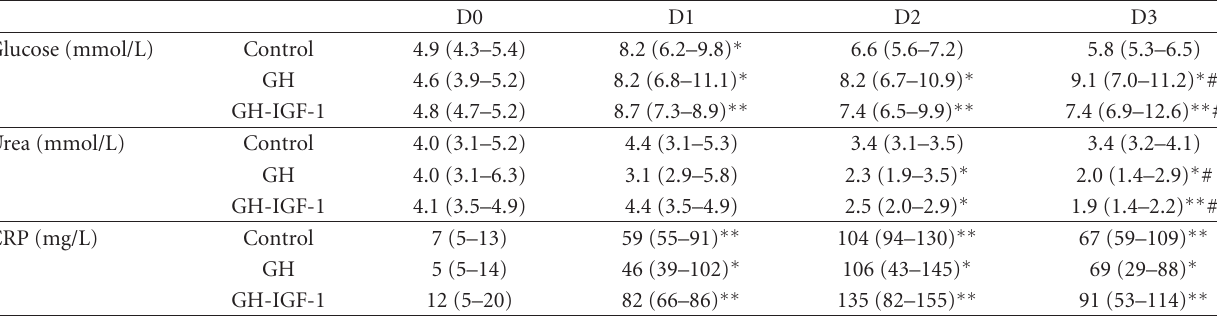
Table 3: Plasma glucose, urea and CRP levels pre- and